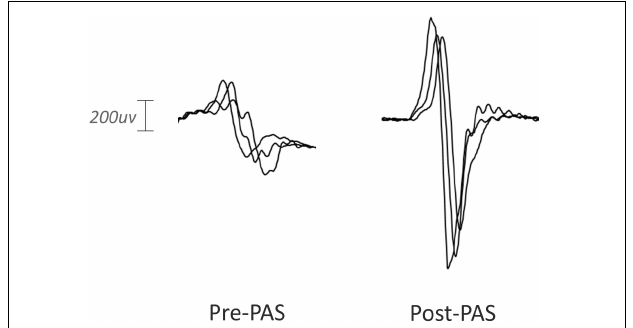
FIGURE 3 | Representative MEP waveforms from a single participant pre and post-PAS intervention. Peak-to-peak MEP amplitude was enhanced by PAS in the baseline session.